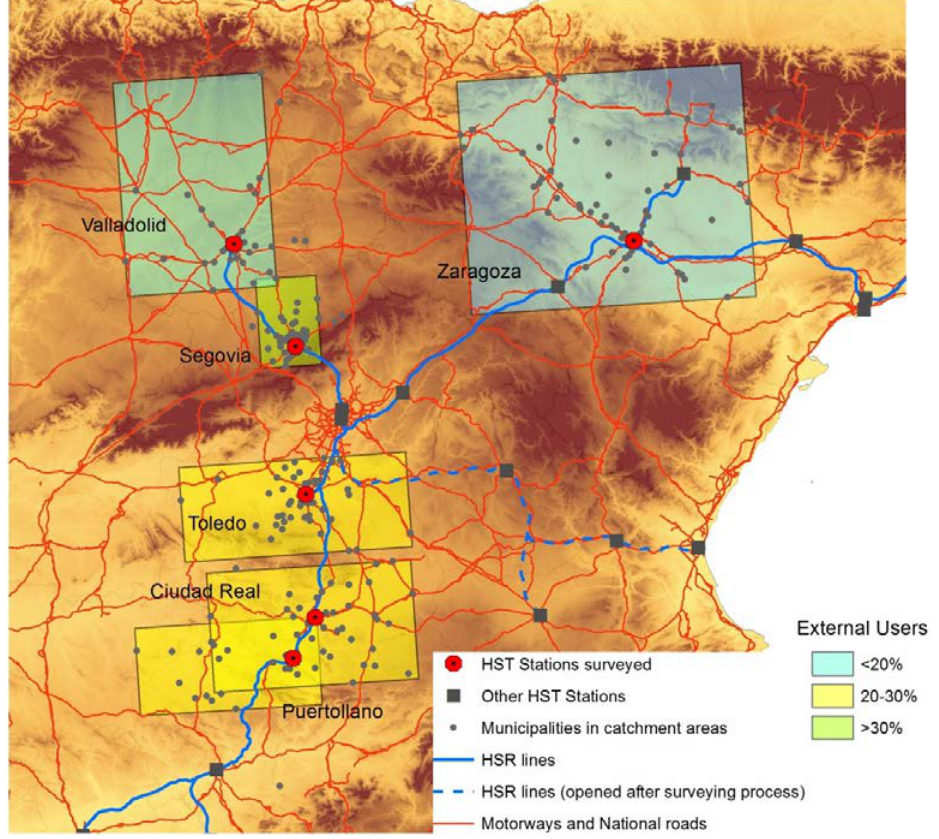
Figure 3. Extension of catchment areas and external use. Source: CNIG, own elaboration.